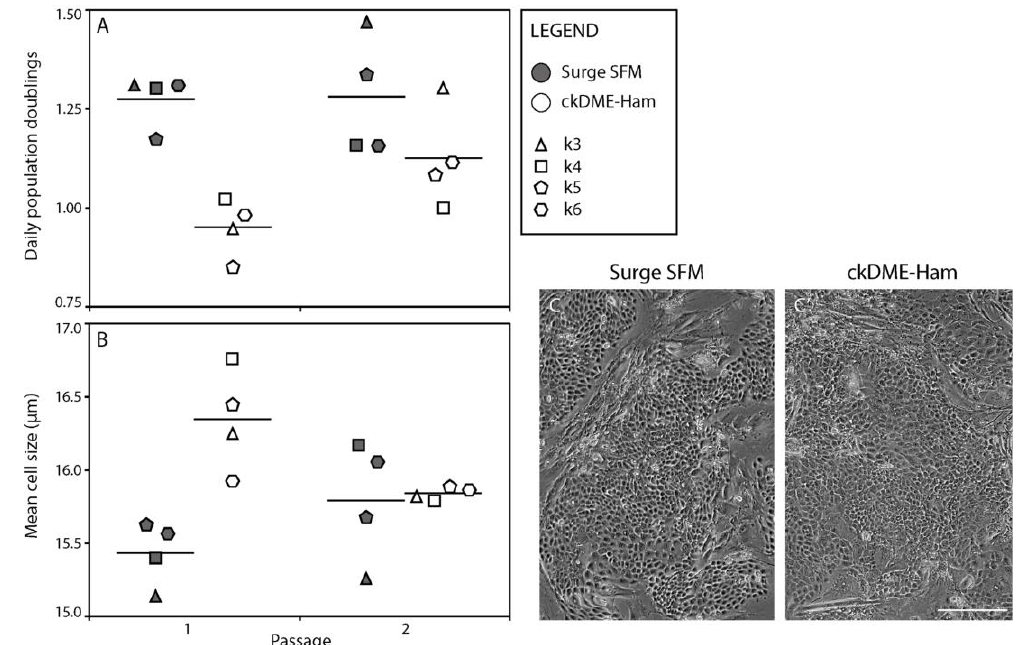
Figure 2. Dot plots of ( A ) the number of population doublings/day and ( B ) the mean cell size (μm) over two passages in culture of primary keratinocytes that were previously cryopreserved. Crossbars represent biological means. Dot fill colors indicate the medium used to culture keratinocytes (gray: Surge SFM and white: ckDME-Ham). Dot shapes identify keratinocyte populations (k3: triangle, k4: square, k5: pentagon, and k6: hexagon). Dots are means of triplicates. ( C , C’ ) Phase contrast micrographs of k4 keratinocytes in P1 after 4 days of culture with either ( C ) Surge SFM or ( C’ ) ckDME-Ham. Sharpness was increased 50% for visual clarity. Scale bar: 50 µm.